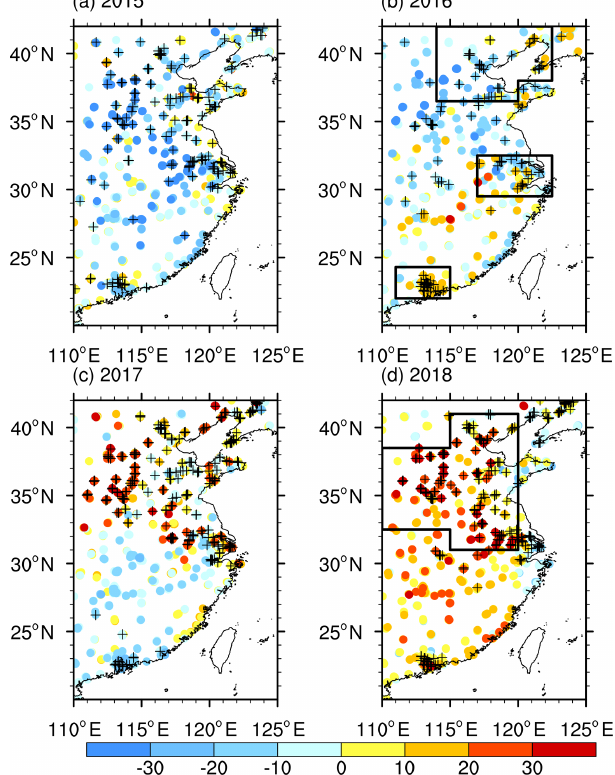
Figure 2. Anomalies of the summer mean MDA8 (unit: µgm − 3 ) in 2015 (a) , 2016 (b) , 2017 (c) and 2018 (d) , relative to the mean dur- ing 2015–2018. The black pluses indicate that the maximum MDA8 was larger than 265µgm − 3 . The black boxes in (b) indicate the lo- cations of NC, YRD and PRD, while that in panel (d) is the NCH